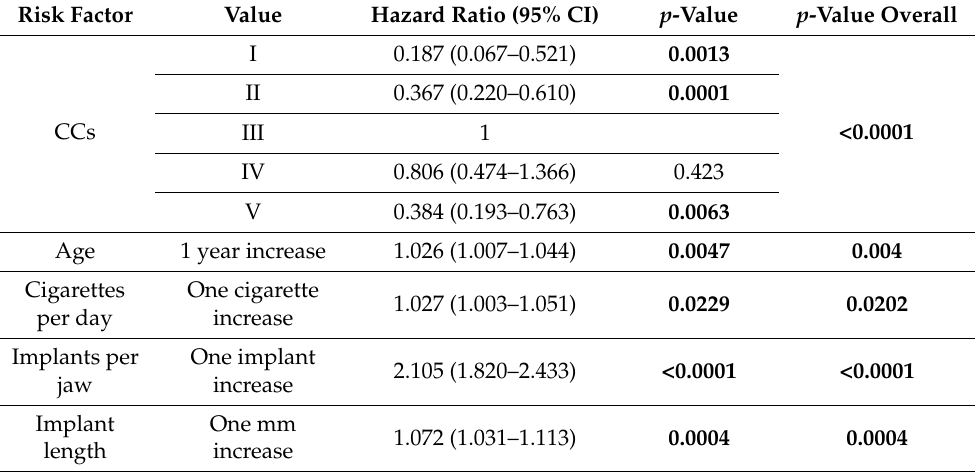
Table 7. The risk of implant loss as a function of potential risk factors after eliminating covariate factors using a mixed Cox regression model. The factors were reduced by backward elimination if displaying p < 0.20 in the one-to-one associations. p -values indicating statistical significance are marked in